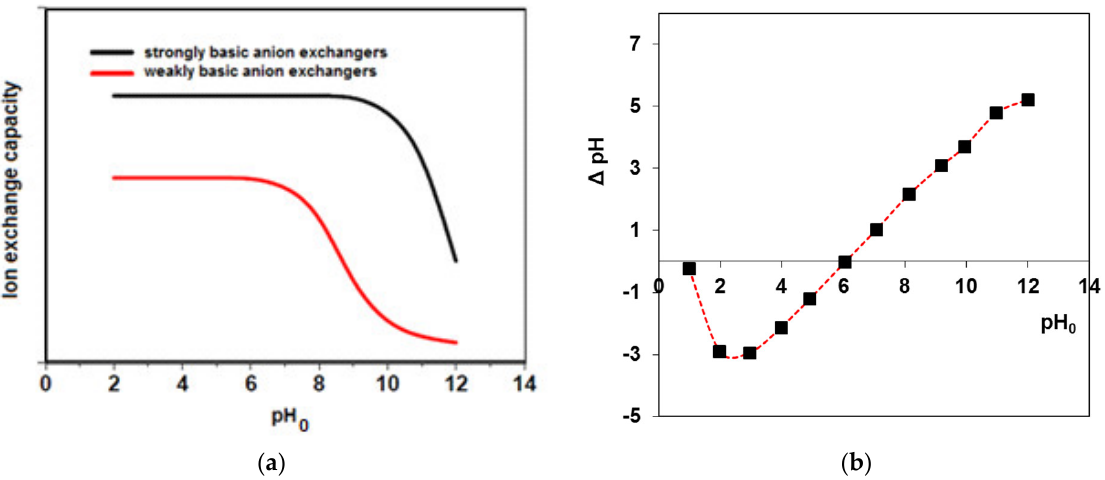
Figure 6. ( a ) Impact of solution pH on the ion exchange capacity of the weakly basic anion exchangers such as A21 resin and ( b ) determination of pH of zero point charge (pH PZC ) of A21 resin.